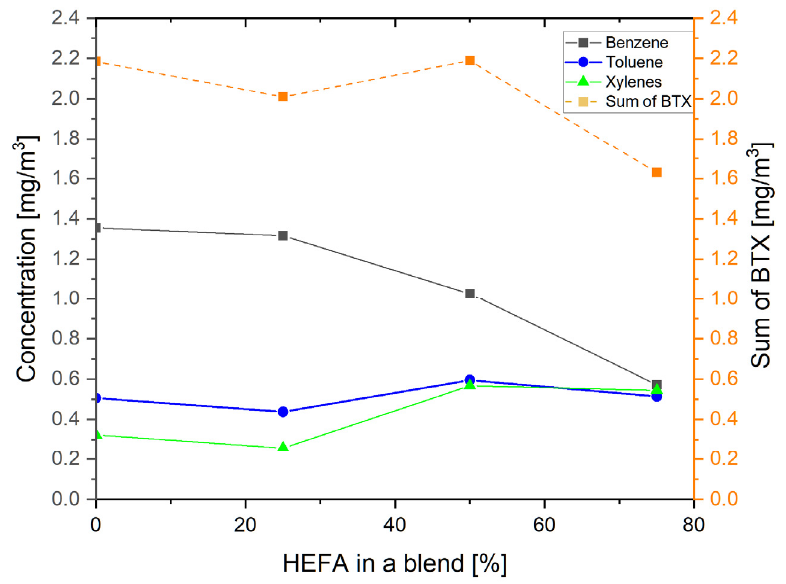
Figure 4. Emission of volatile organic compounds depending on the share of the synthetic component in the tested fuel blend.